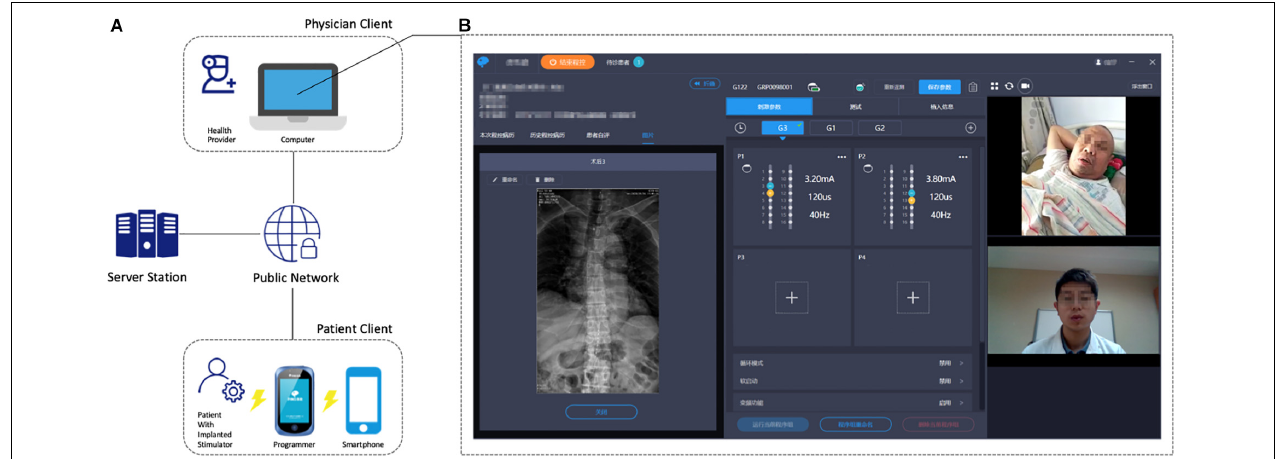
FIGURE 1 | (A) General architecture of the remote programming system. (B) Physician client illustration with the real-time video consultation (right), parameter and configuration adjustment (middle), and the patient’s medical record (left). The patient sent a WebRTC request to the signaling server, which is subsequently relayed to the physician client. If an online physician replies to the WebRTC request, a P2P connection will be established, and video stream is facilitated between the two